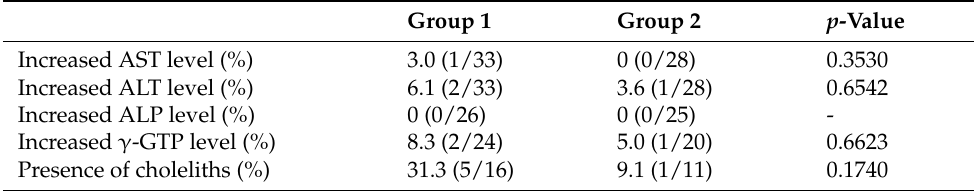
Table 4. Safety data of the registered